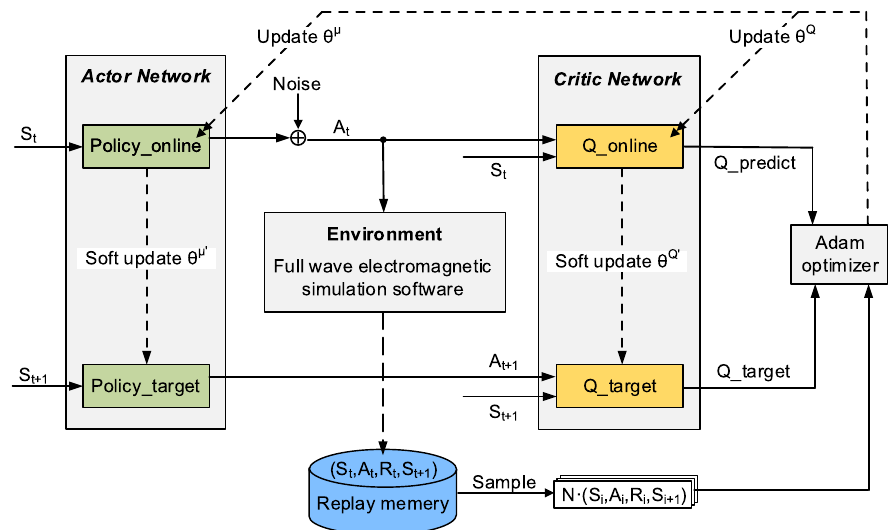
Figure 24. Framework of the DDPG. Reprinted/adapted with permission from Ref. in [85].